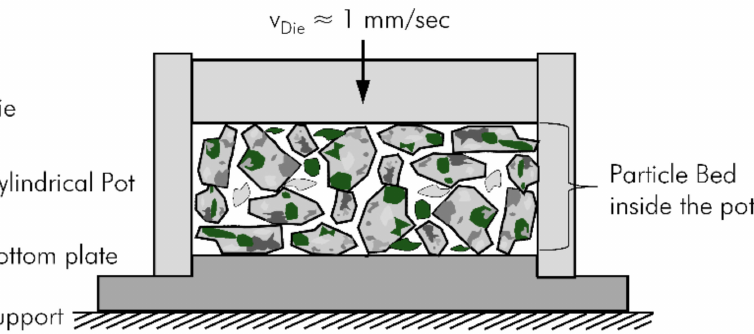
Figure 2. Experimental setup of the particle bed test in a schematic sectional